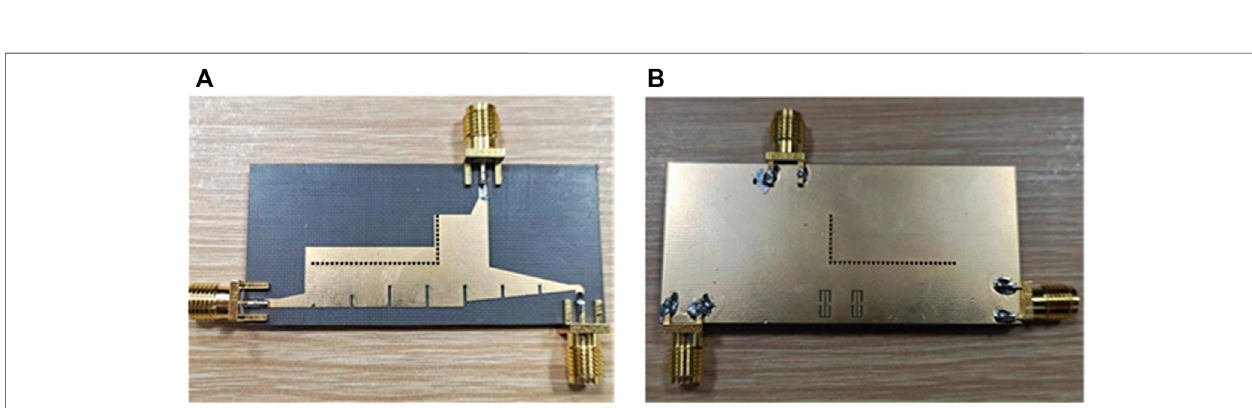
FIGURE 7 | (A) Top view and (B) back view of the prototype.